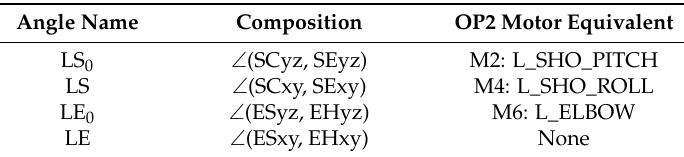
Table 1. Comparison of human movement to its equivalent performance through OP2. Right side motors (not listed) are equivalent to the left side motors shown.